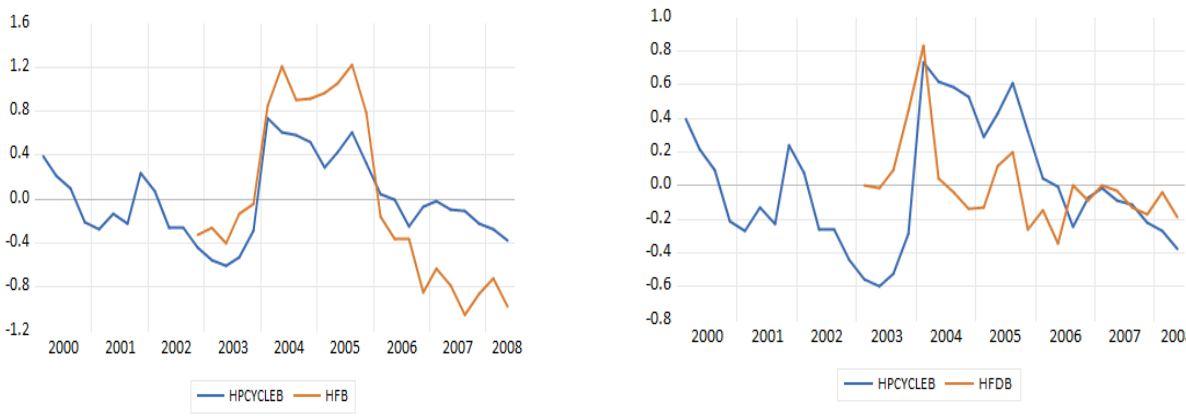
Figure 3. HP (1600) filter (blue) versus 2-year regression filter HF (brown), second period.